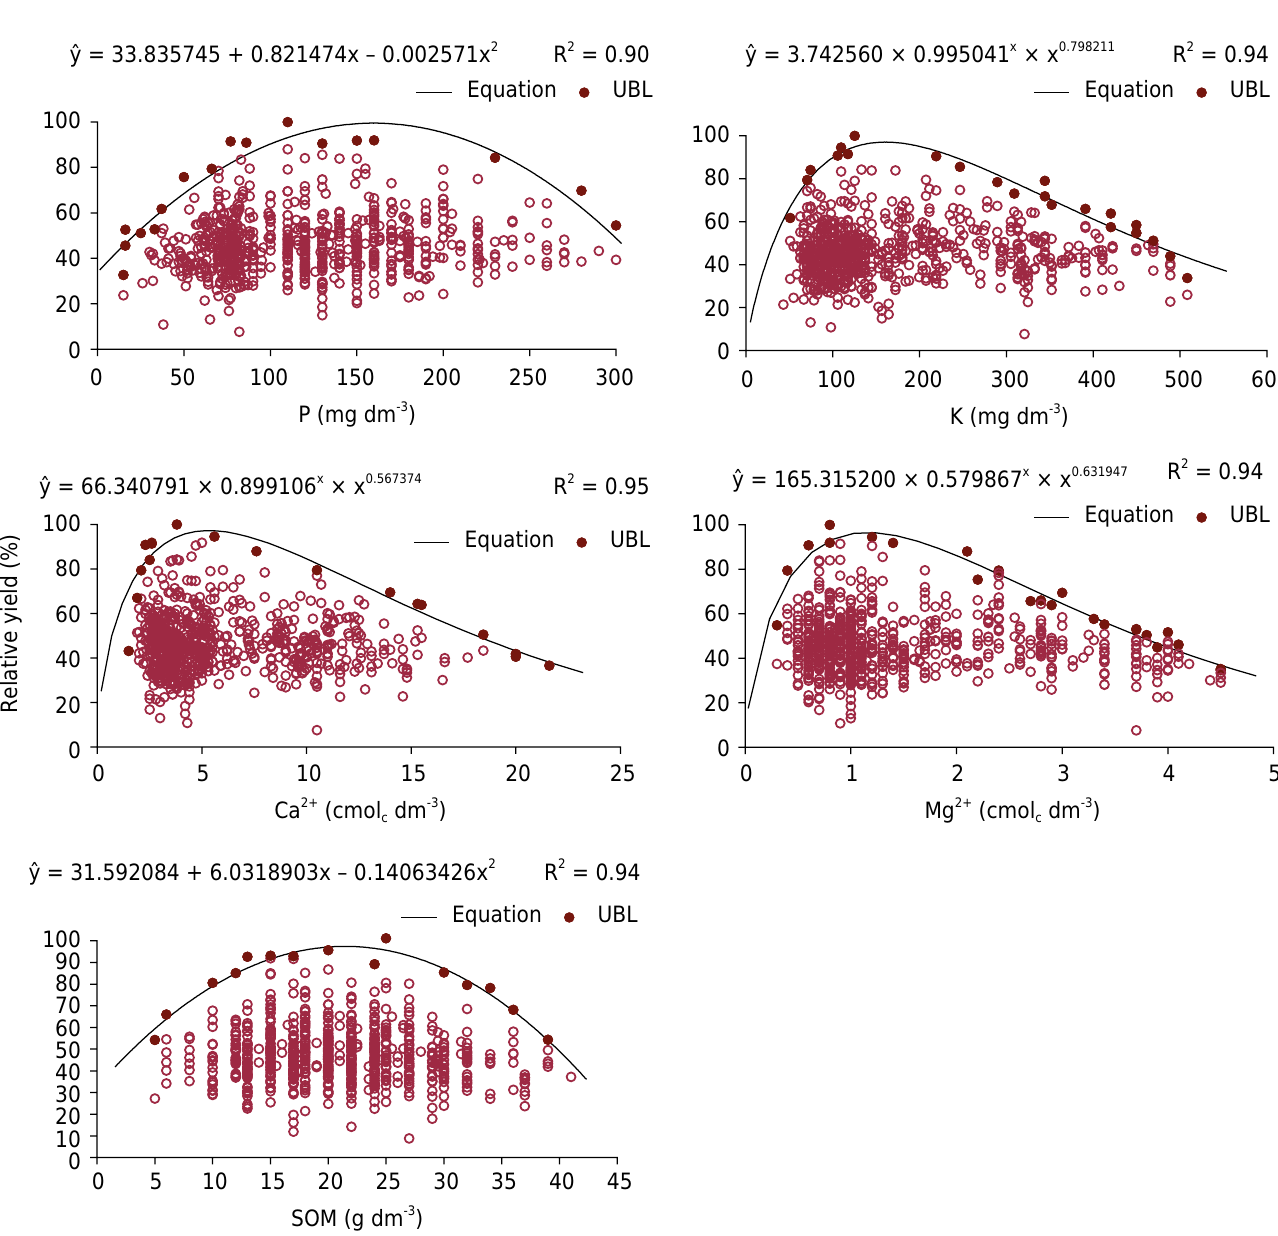
Figure 4. Upper boundary line obtained for relative yield (%) as a function of the contents of P and K (mg dm -3 ), Ca 2+ , and Mg 2+ (cmol c dm -3 ), and soil organic matter (g dm -3